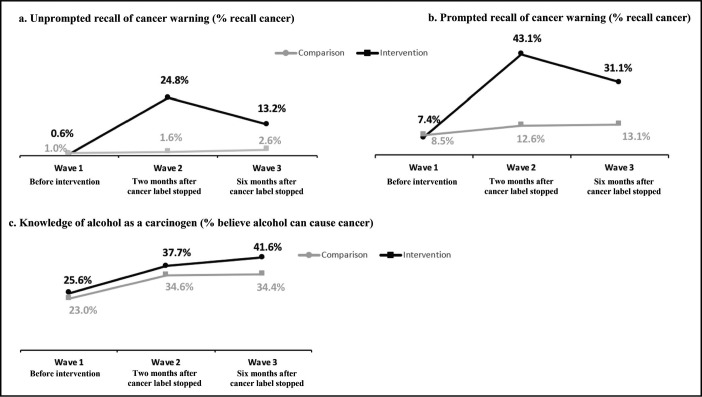
(a–c). Percentage of participants recalling cancer warning, unprompted and prompted, and knowledge of alcohol as a carcinogen across survey waves in intervention and comparison sites